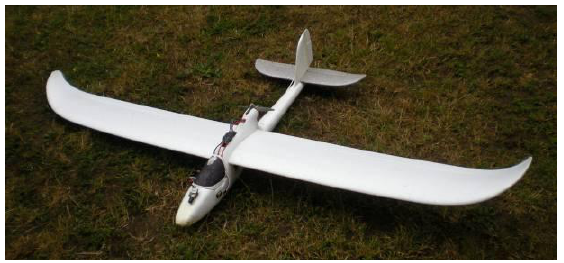
Figure 1. The ‘Easy Star XXL’ model airplane